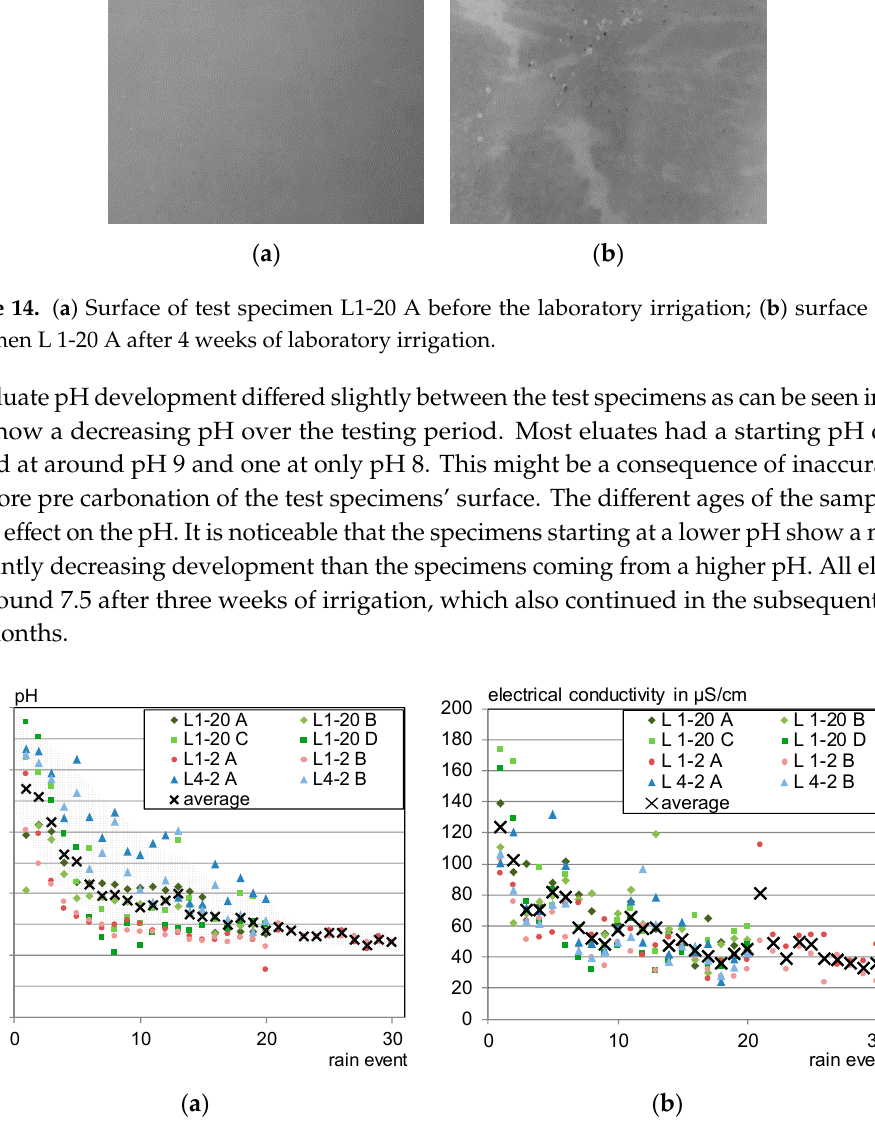
Figure 15. ( a ) Development of the eluate pH in the laboratory irrigation experiment; ( b ) development of the electrical conductivity in the laboratory irrigation experiment.